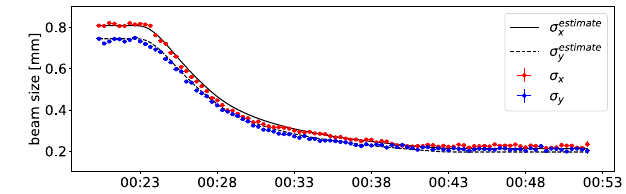
FIG. 14. Distribution of independent beam size measurements for two integration times. Black lines are fits with a normal distribution, whose width reflects the statistical error of the BGV beam size measurement.